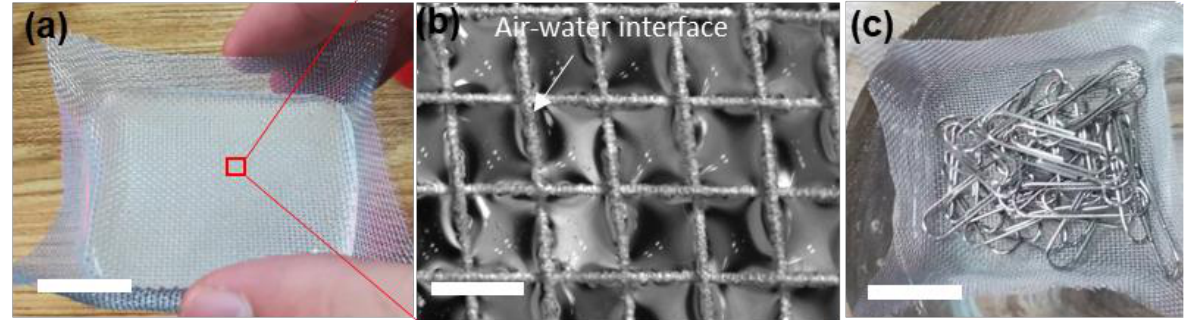
Figure 2. ( a ) Superhydrophobic bowl that could carry water. ( b ) Air – water interface at the bottom